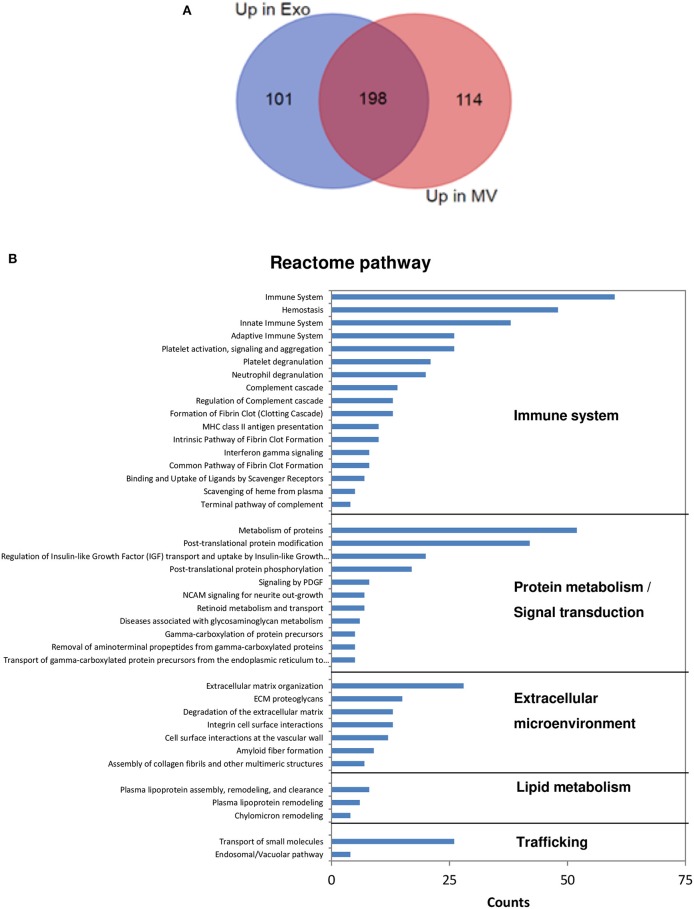
Analysis of proteins overexpressed in NKExo and/or NK-cell-derived microvesicle (NKMV). (A) Venn diagram displaying unique and shared overexpressed proteins in NKExo (Up in Exo) and NKMV (Up in MV). (B) Reactome pathway annotation of proteins overexpressed in NKExo and/or NKMV obtained by Search Tool for the Retrieval of Interacting Genes/Proteins (STRING). The number of proteins (counts) involved in each Gene Ontology (GO) term is displayed.